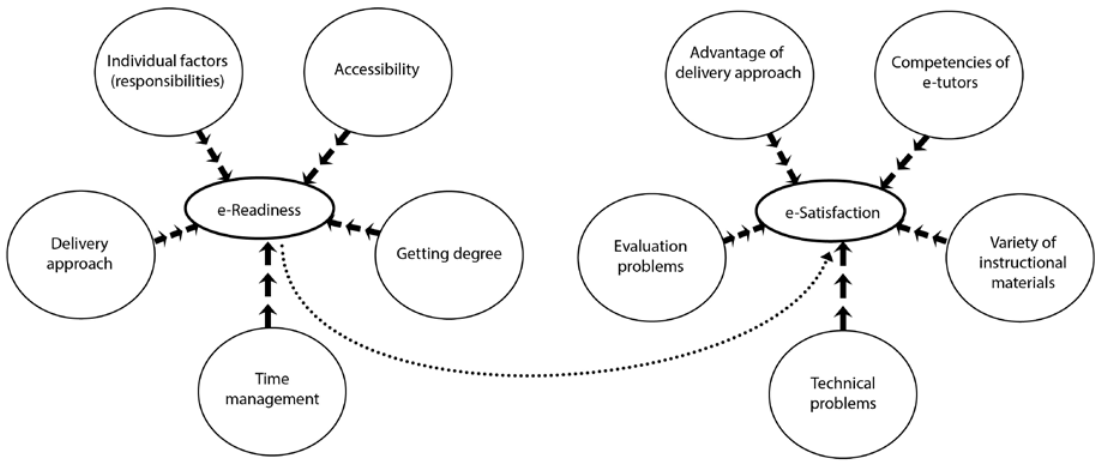
Figure 3 . Major variables affecting readiness and